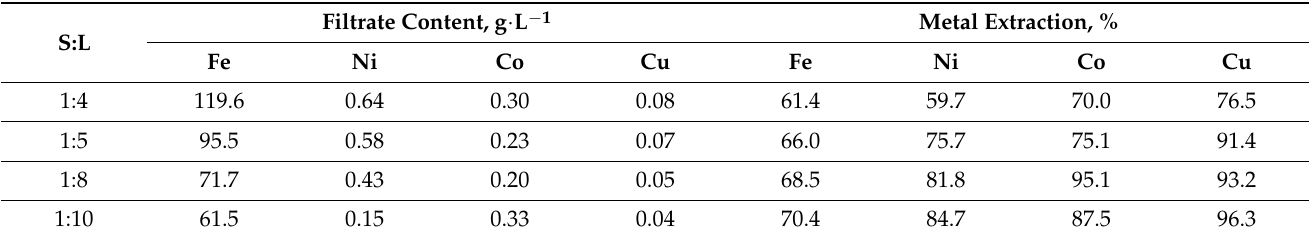
Table 3. The influence of solid-liquid ratio on the leaching of a slag sample 774. Conditions: t = 80 ◦